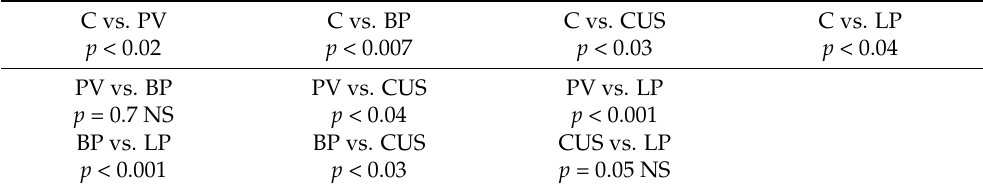
Figure 3. ( A ) Immunohistochemistry. JAK3 expression in epithelial cells and inflammatory influx. PV. 200× mag. ( B ) Immunohistochemistry. JAK3 expression in epithelial cells and inflammatory influx. BB. 400× mag. ( C ) Immunohistochemistry. JAK3 expression in epithelial cells and inflammatory influx. CUS. 400× mag. ( D ) Immunohistochemistry. JAK3 expression in epithelial cells and inflammatory influx. LP. 400× mag. ( E ) Comparison of JAK3 in PV, BP, CUS, LP and healthy mucosa ( C ). Table 4. Expression of JAK3 in study groups. C—control group; BP—pemphigoid; PV—pemphigus vulgaris; LP—lichen planus; CUS—chronic ulcerative